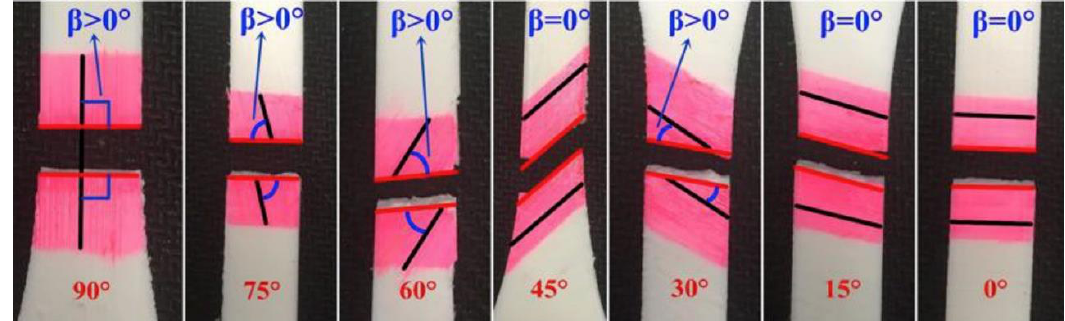
Figure 4. Ultimate tensile strength testing of polylactic acid (PLA) materials and their respective printing angles. Reprinted with permission from [126] . printing angles. Reprinted with permission from